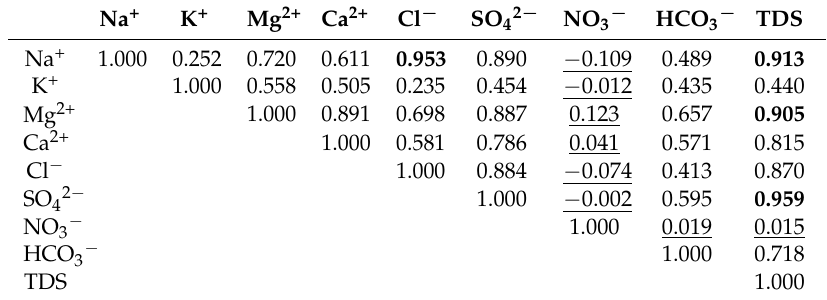
Table 1. Correlation coefficient matrix of eight ions and TDS (log-transformed